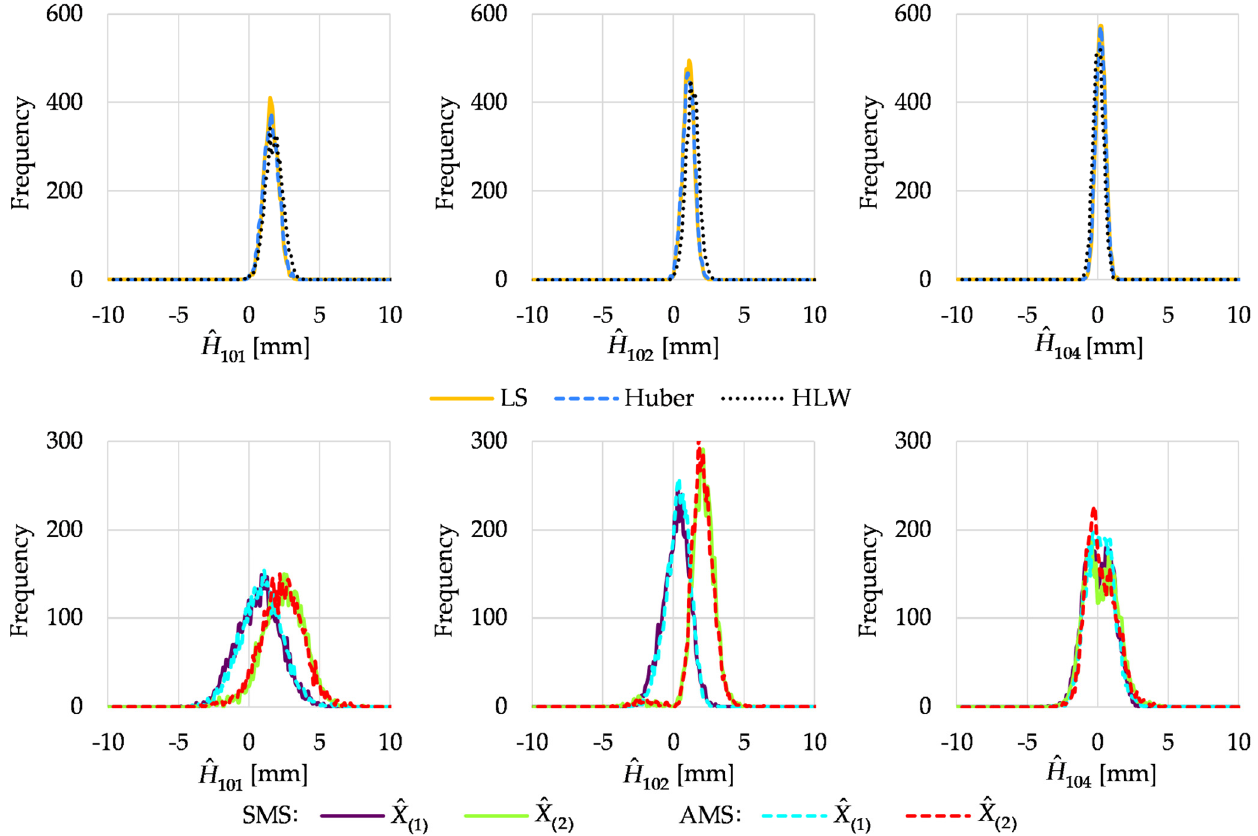
Figure 5. Histograms of estimated point heights in Variant IV. Table 1. Medians (mm) of the chosen object point height estimates from